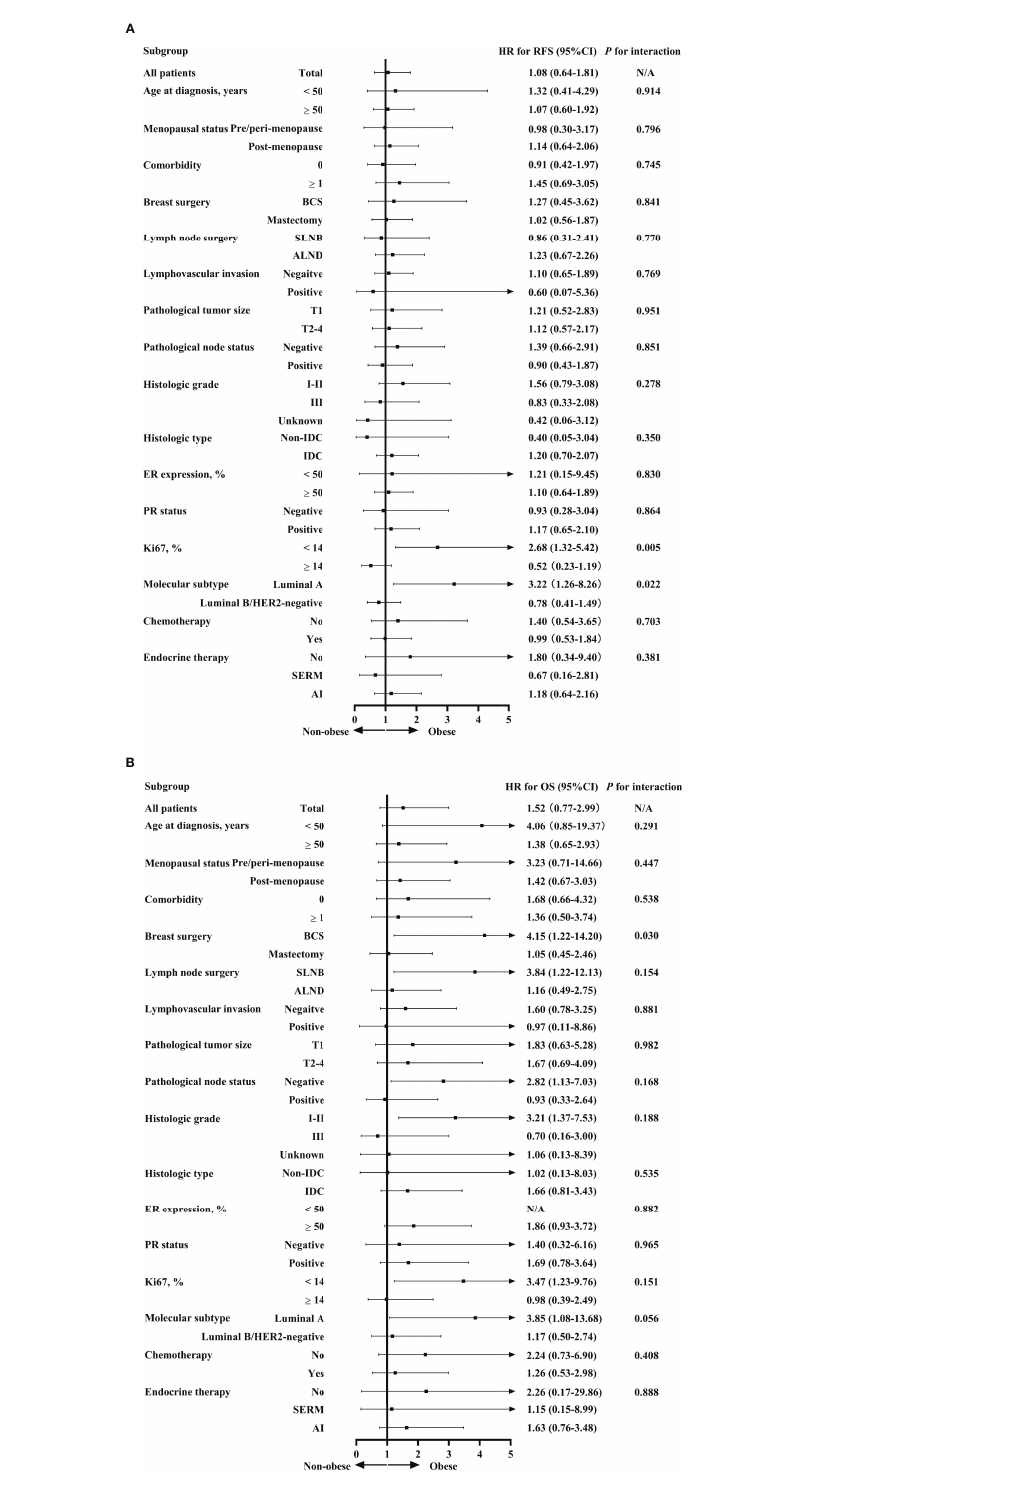
FIGURE 3 | Interaction between BMI and clinicopathological characteristics in predicting RFS (A) and OS (B) . BMI, body mass index; RFS, relapse-free survival; OS, overall survival; HR, hazard ratio; CI, con fi dence interval; BCS, breast conservative surgery; SLNB, sentinel lymph node biopsy; ALND, axillary lymph node dissection; IDC, invasive ductal carcinoma; ER, estrogen receptor; PR, progesterone receptor; HER2, human epidermal growth factor receptor 2; SERM, selective estrogen receptor modulators; AI, aromatase